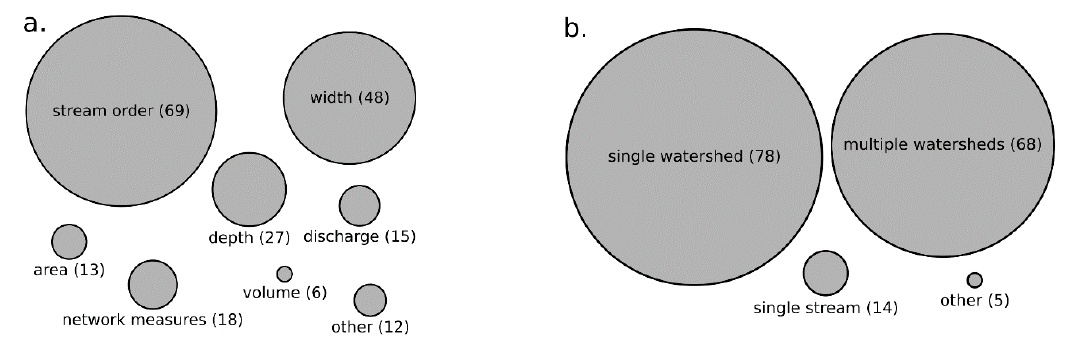
Figure 3. Measures of stream size used to infer biodiversity–stream size relationships ( a ) Network measures includes measures such as link distance from source, downstream, links magnitude, and several other measures. Geographic scale of studies inferring relationships between stream size and biodiversity ( b ) The category “other” includes continental, global, and single reach.